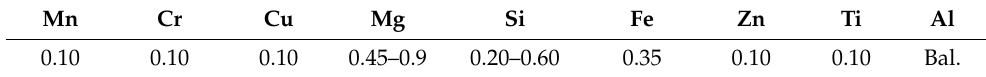
Table 3. Chemical composition of 6063 aluminum alloy (mass fraction,